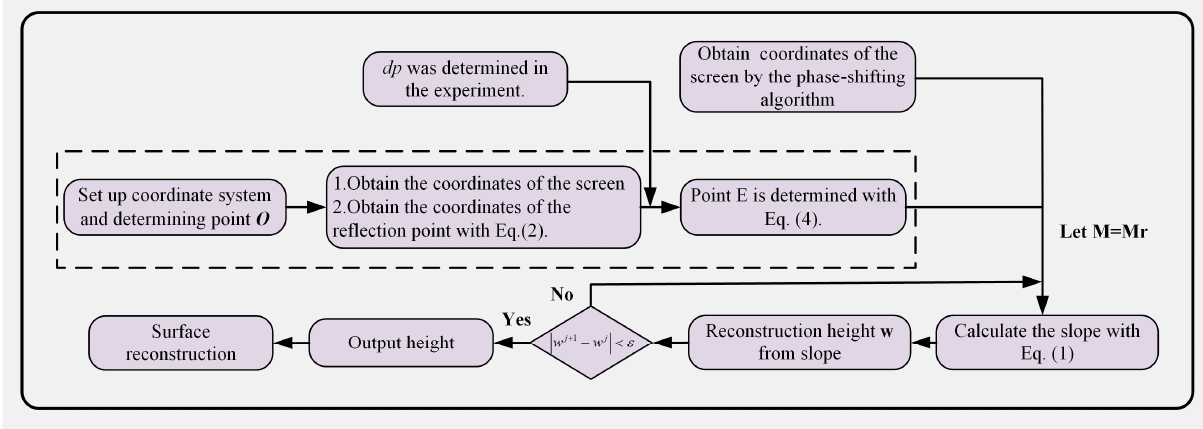
Figure 3. Flow chart of EPCM.